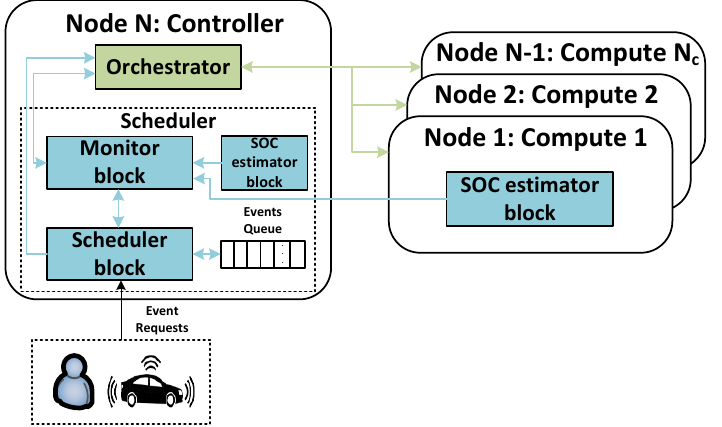
Figure 2. Scheduling module design and the relation among its different